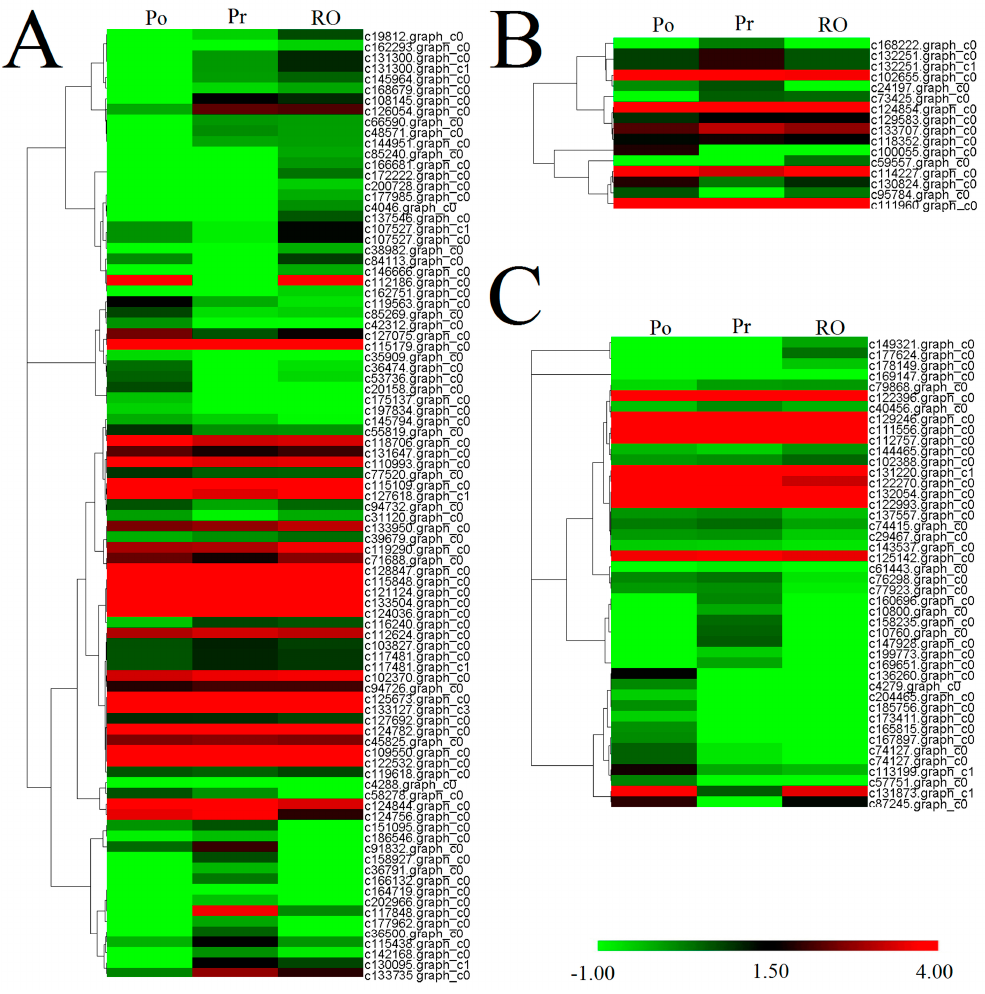
Figure 7. All unigenes encoding the R2R3-MYB ( A ), bHLH ( B ) and WD40 ( C ) transcription factors were hierarchically clustered and mapped using the FPKM values. Colors indicate log2 transformed FPKM values. Green indicates low expression, and red indicates high expression.